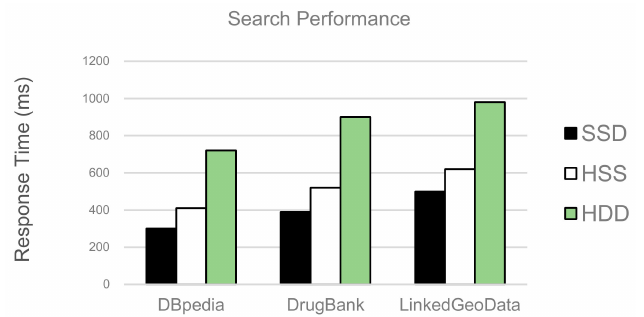
Figure 14. Search performance of storage structures.